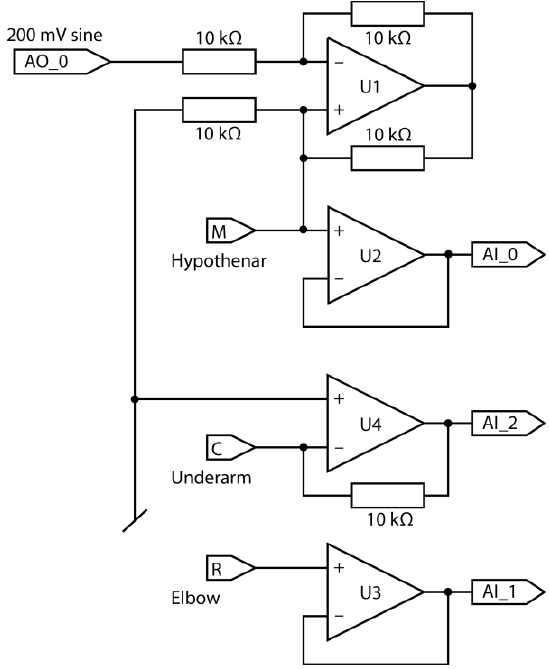
Figure 1: Circuit for simultaneous measurement of skin conductance, susceptance and potential.